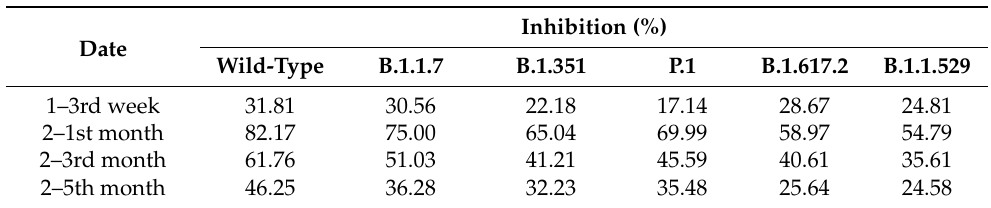
Table 2. The average inhibition rates of antibodies induced by inactivated vaccines (CoronaVac/BBIBP-CorV).